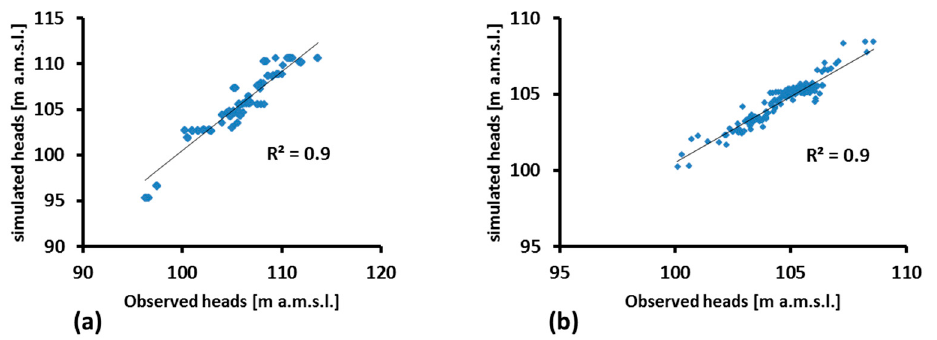
Figure 3. Model simulated vs. field observed water level: ( a ) Calibration period and; ( b ) validation period.